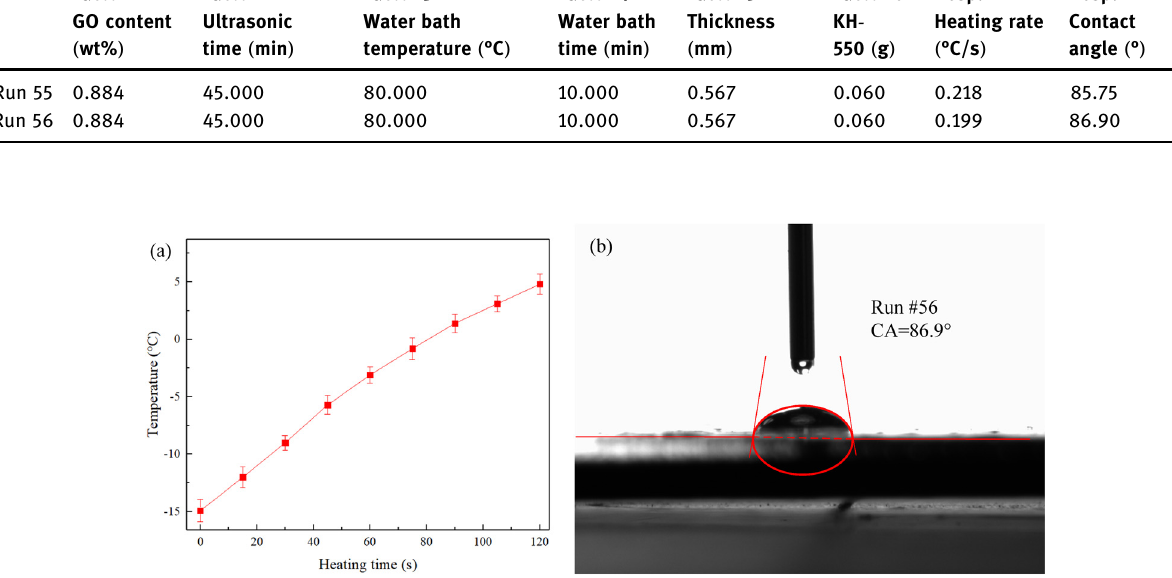
Table 6: Comprehensive optimization of optimal process parameters Factor 1